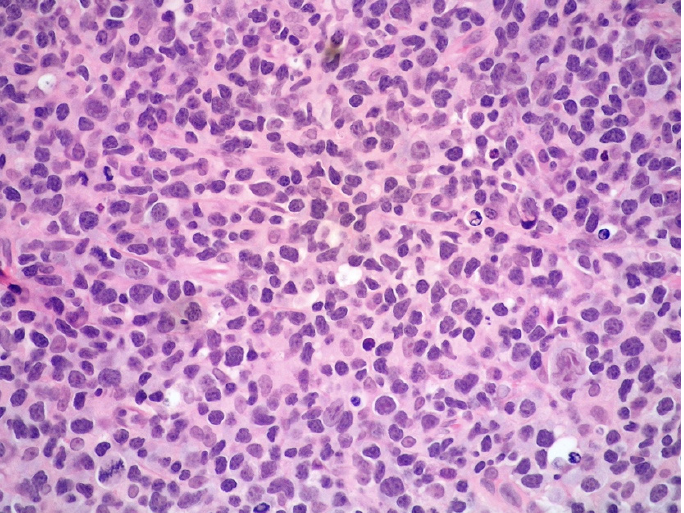
Figure 6. High-power view showing a diffuse and polymorphic proliferation of atypical, medium- to large-sized lymphoid cells (hematoxylin and eosin, 200× magnification, previously unpublished, original image from